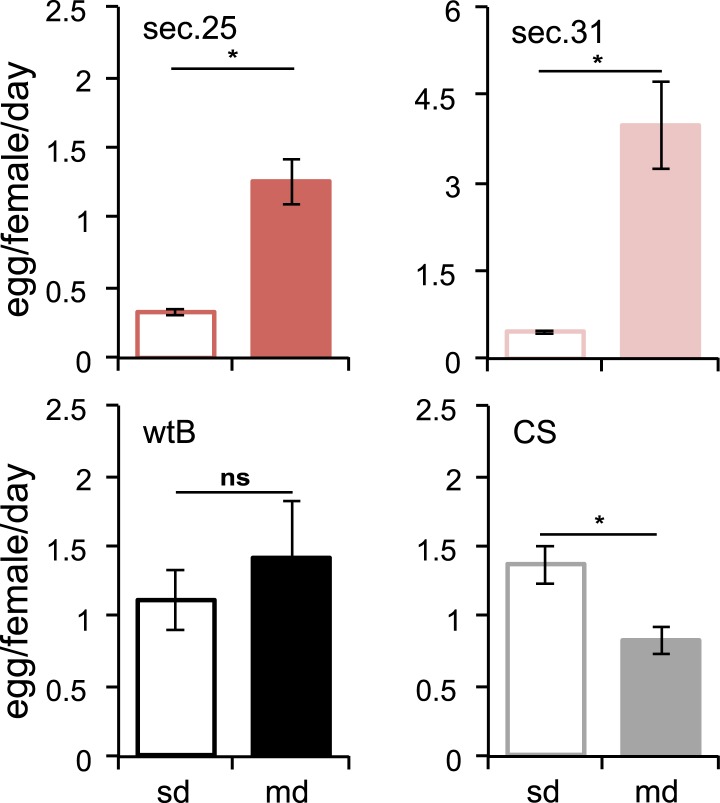
Morinda stimulates egg production in D. sechellia.Egg production (egg/female/day) in D. sechellia 14021–0248.25 (sec.25, N = 3), D. sechellia 14021–0248.31 (sec.31, N = 3), D. melanogaster wild-type Berlin (wtB, N = 3) and D. melanogaster Canton-S (CS, N = 3), fed a standard diet (sd) or morinda diet (md). ns = non-significant, *p < 0.05 using Student's t test to compare diets in each group. Error bars represent s.e.m.